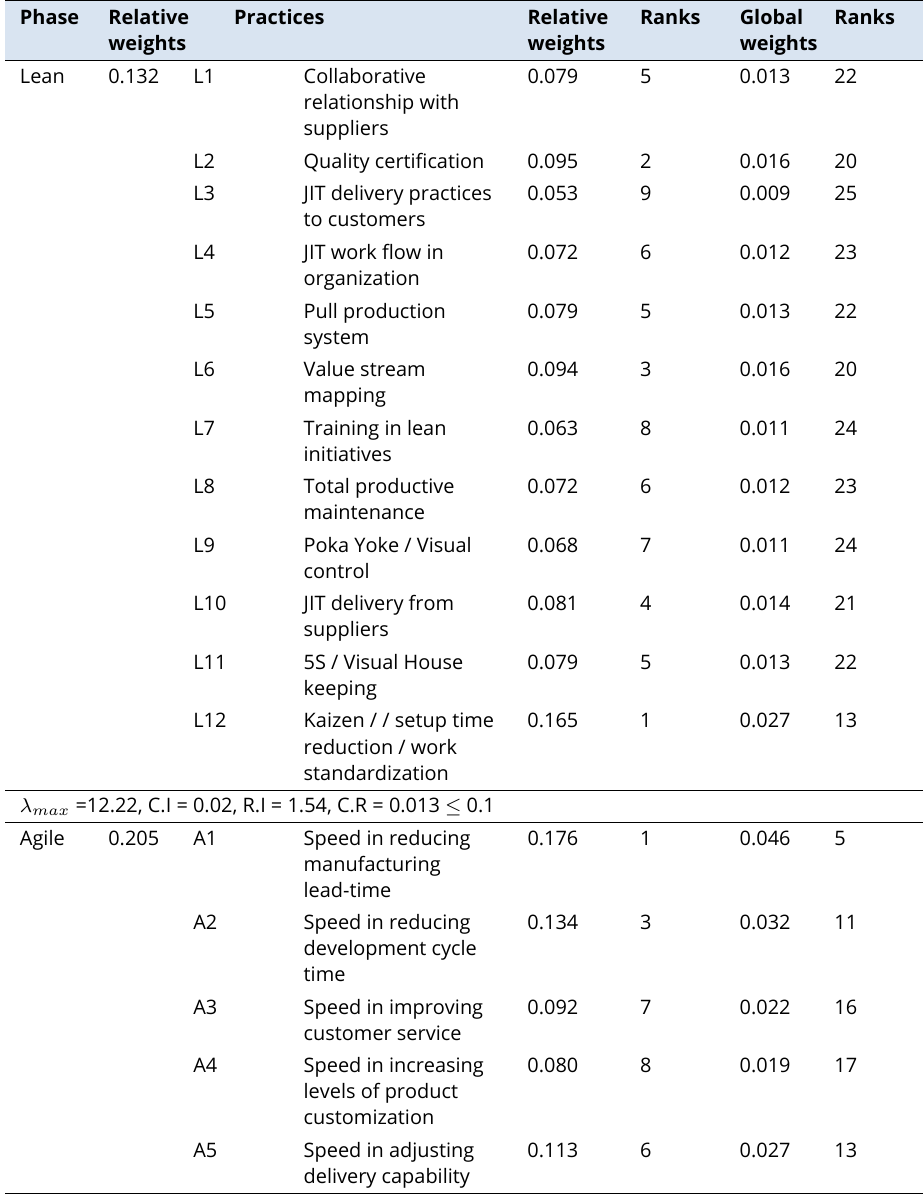
Table 5. LARG – practices consolidated